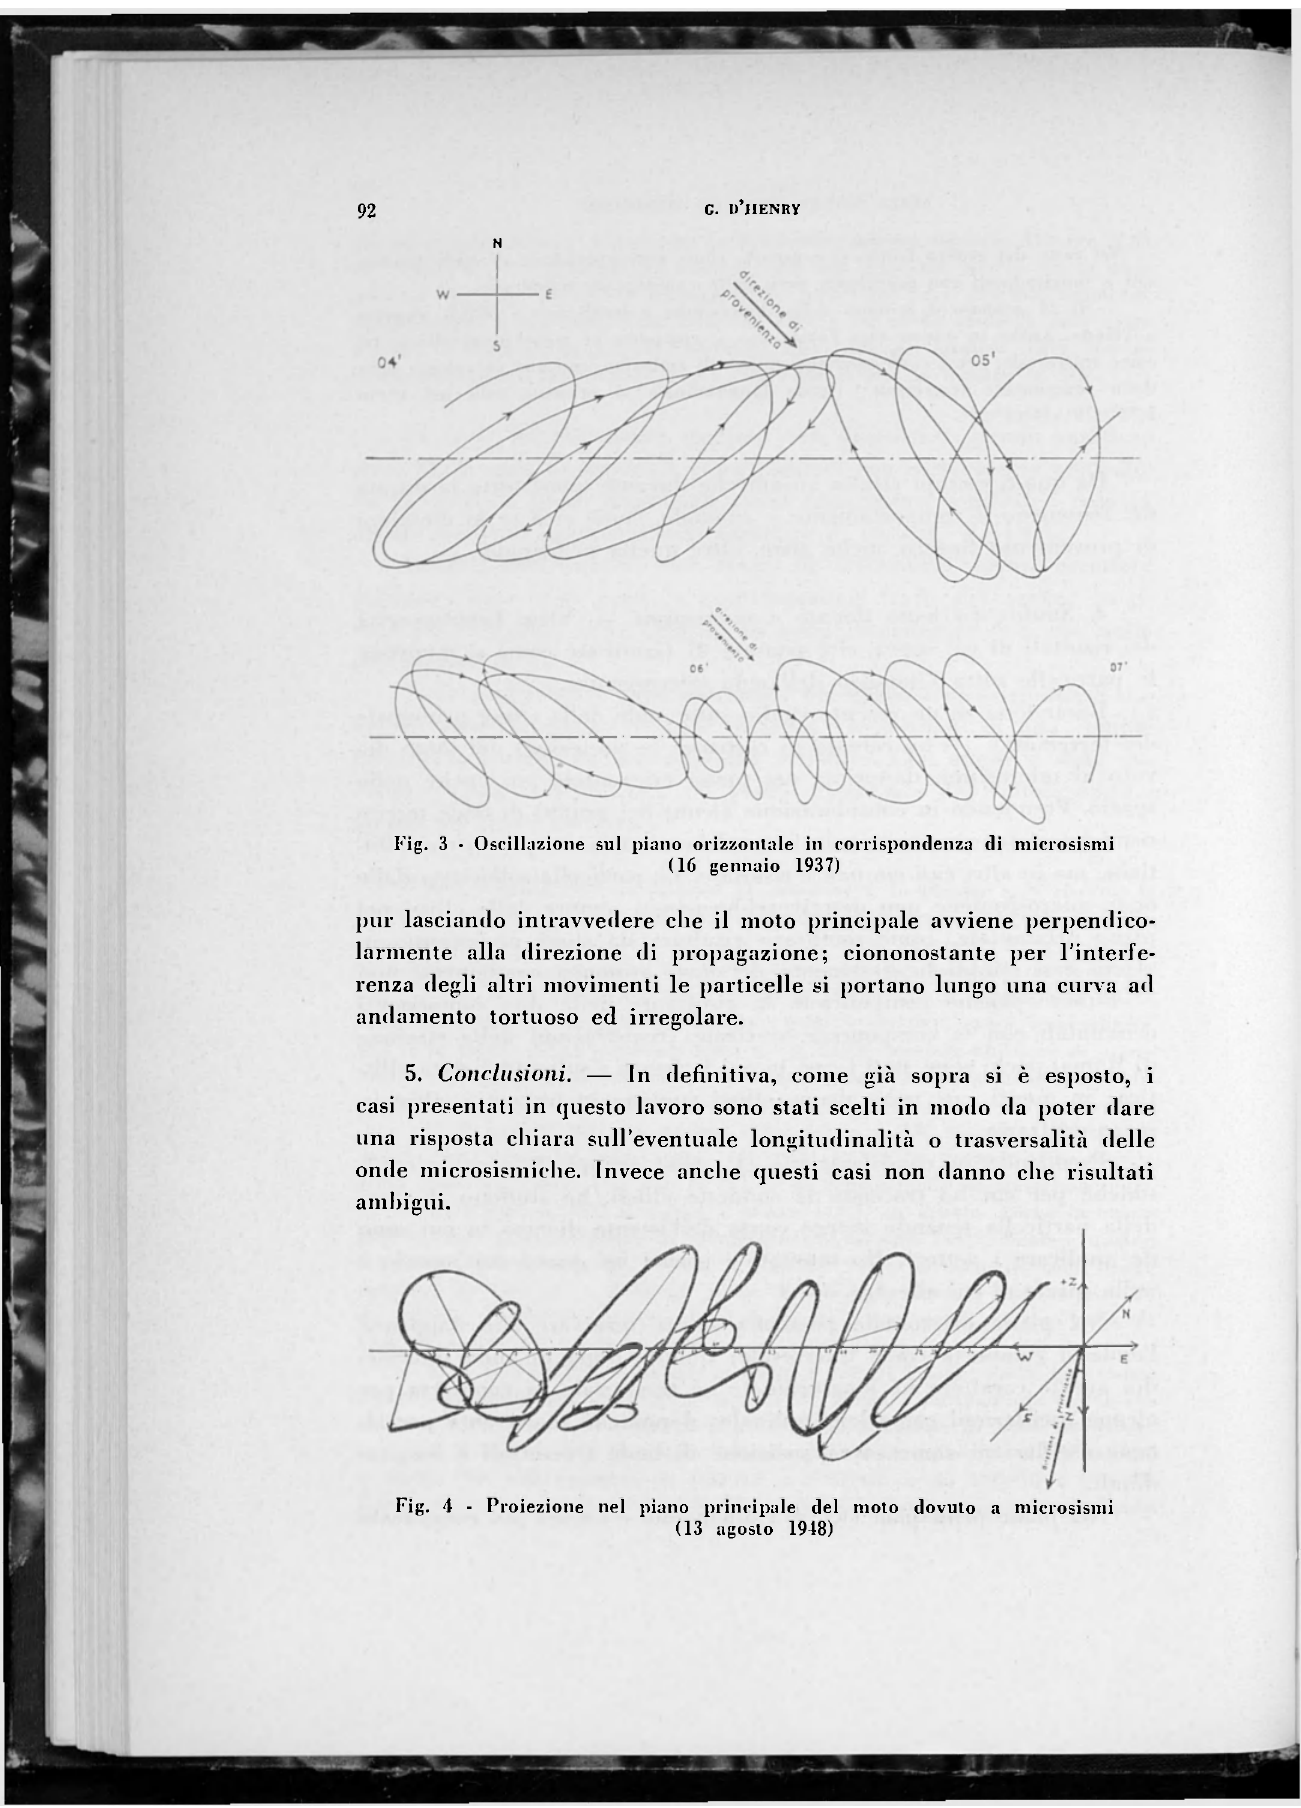
Fig. 3 - Oscillazione sul piano orizzontale in corrispondenza di microsismi (16 gennaio 1937)